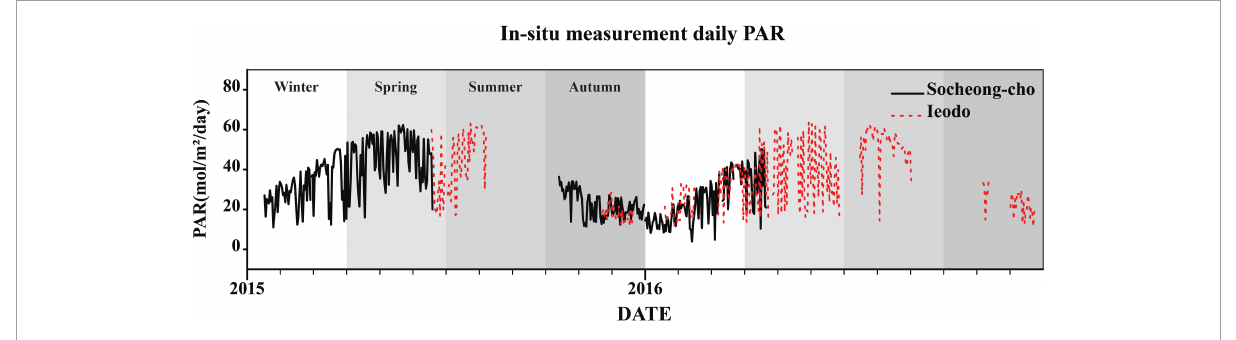
FIGURE 2 Daily PAR measured in situ at Socheong-cho and Ieodo stations in 2015 and 2016.